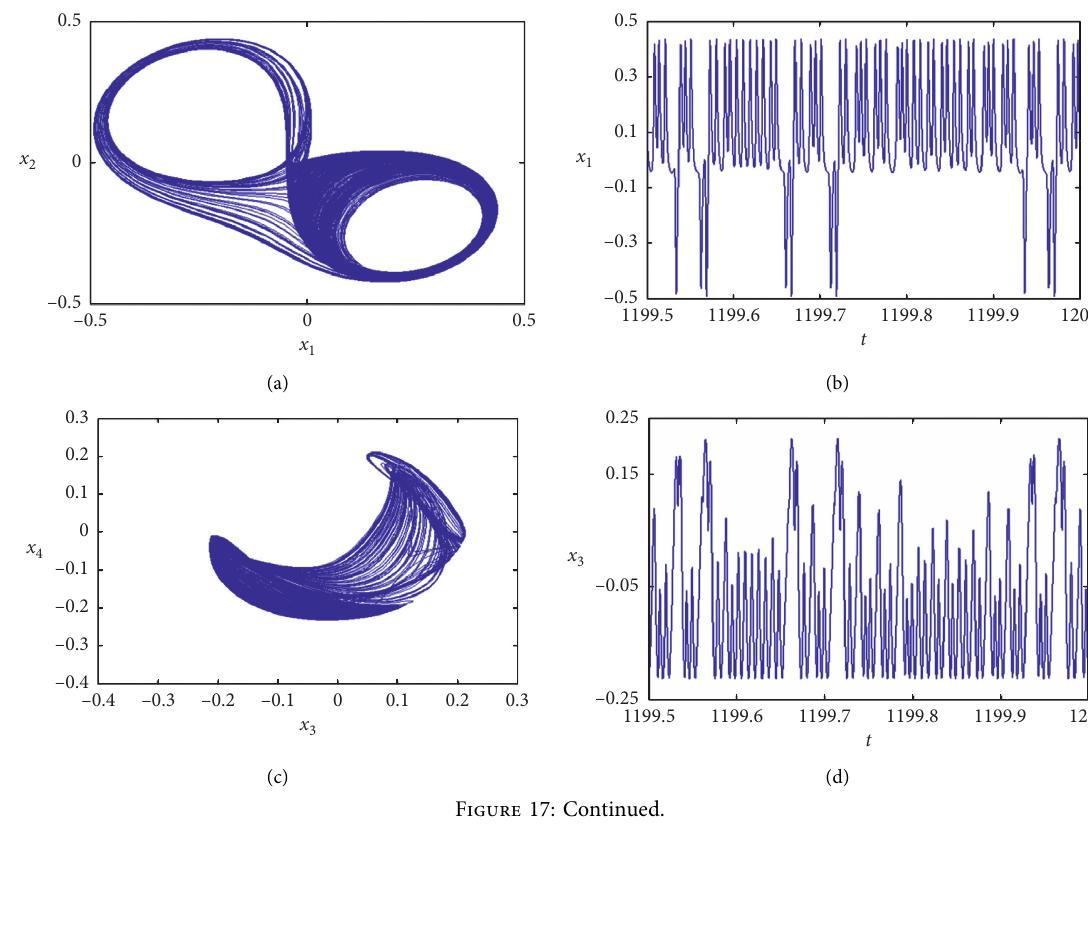
, x ) , (b) waveform on plane ( t, x ) , (c) phase portrait on plane ( x 1 2 1 ,x , x ) , and (g) Poincare map on plane ( x 1 2 3